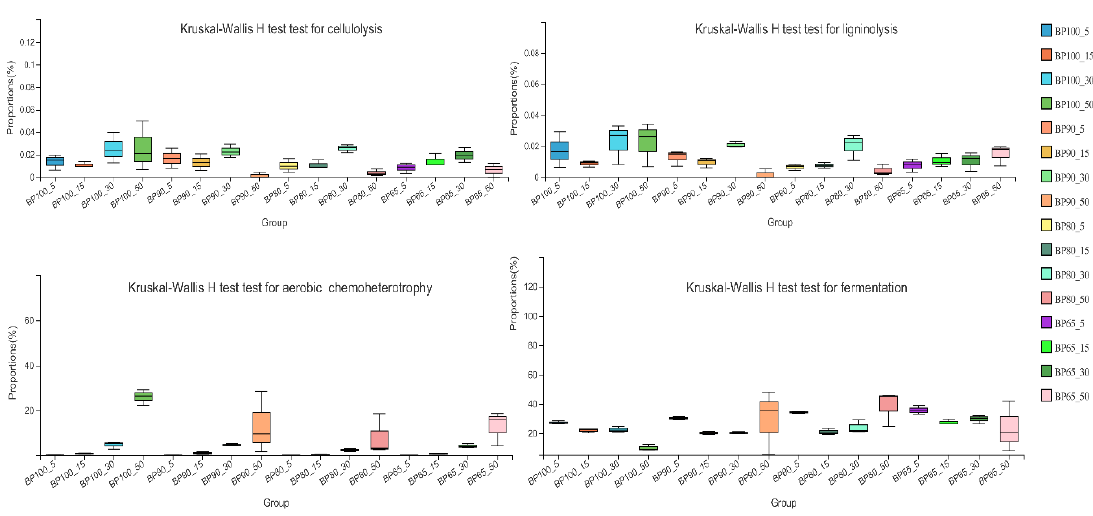
Figure 7. Functional bacterial community categories inferred by FAPROTAX function prediction.